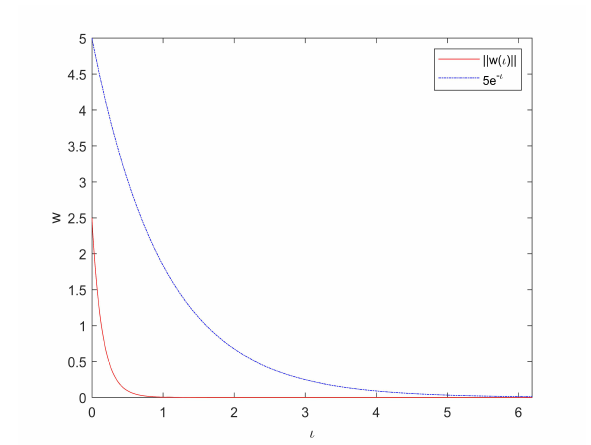
Figure 2. The exponentially stable solution of model